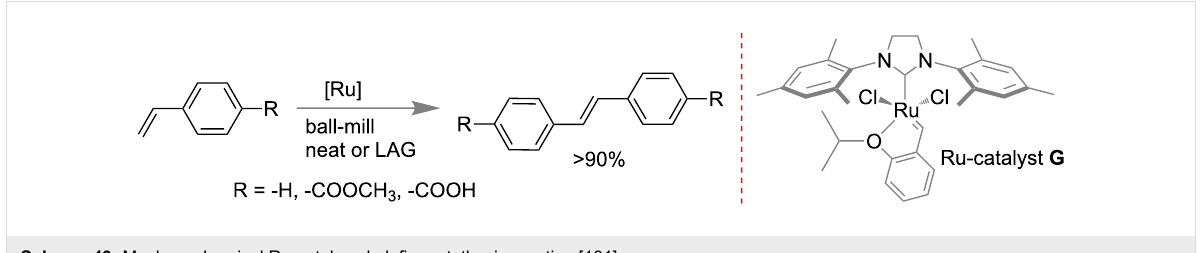
Scheme 49: Mechanochemical Ru-catalyzed olefin metathesis reaction [181].